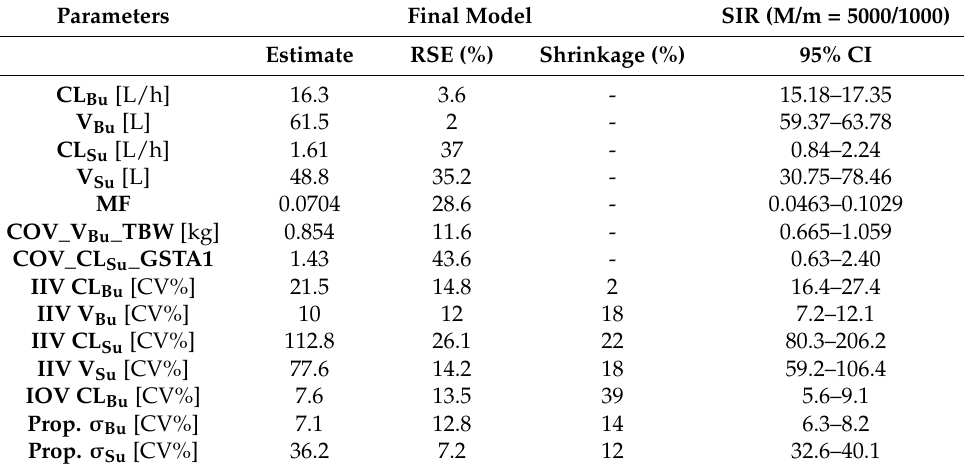
Table 2. Parameter estimates of the final busulfan and sulfolane PK model and SIR results.